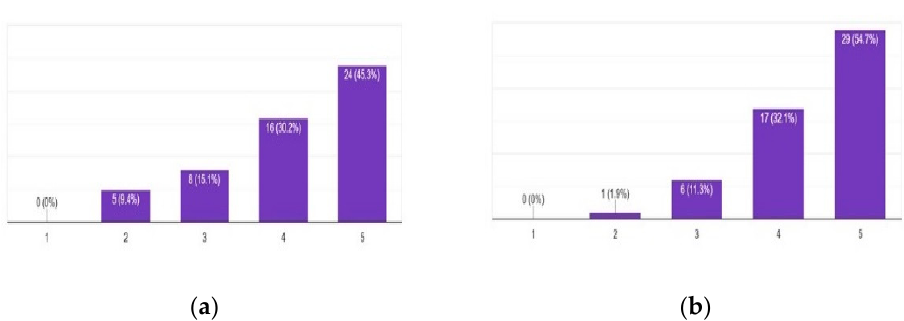
Figure 18. Participants’ opinion: ( a ) the teamworking experience enhances students’ self-esteem; ( b ) the teamworking experience results in team bonding.